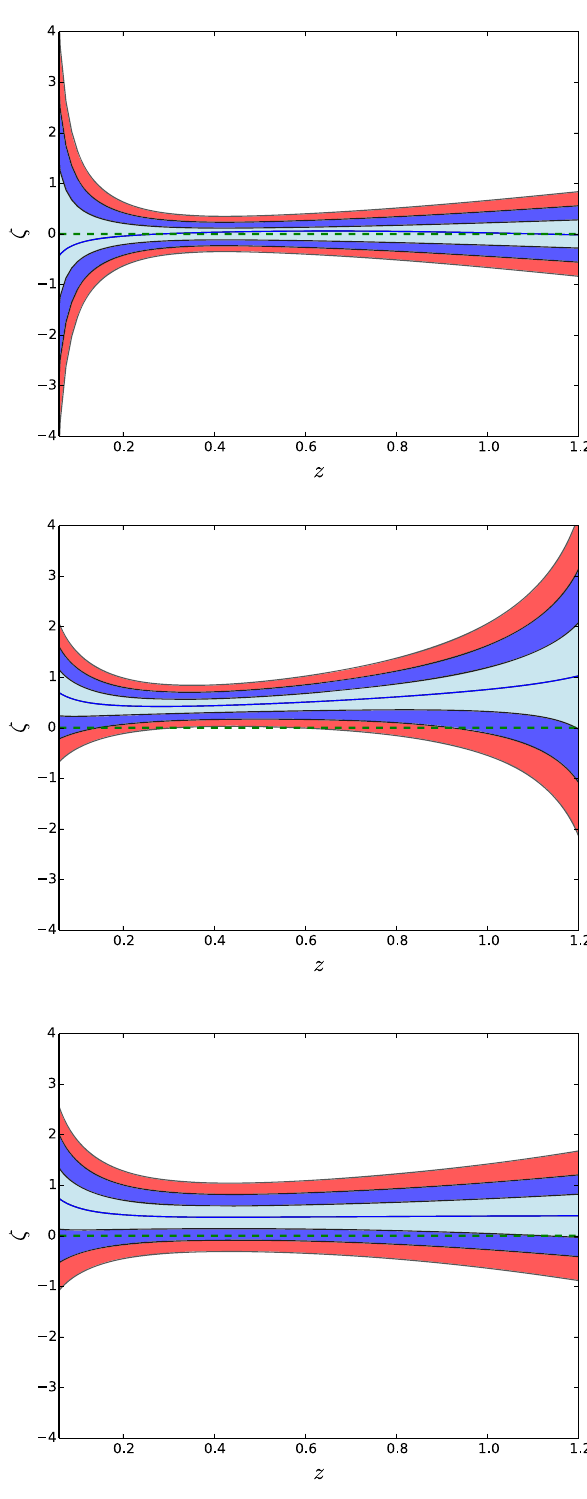
Fig. 7 The results for the reconstruction of the null test for the non-flat (cid:2) CDM using Hubble parameters measurements with 1 σ , 2 σ and 3 σ of C.L. In the figure above we can see the reconstruction of the null test using GP and the best-fit of PLANCK/2018. In the middle figure we show the reconstruction using the H 0 = 74 . 03 ± 1 . 42 of RIESS et al./2018. In the figure below we maintain the value of the Hubble constant of RIESS et al. and use (cid:5) m 0 = 0 . 28 ± 0 . 01. The dashed line represents the flat (cid:2) CDM model and the solid blue line represents the average value of the ζ test